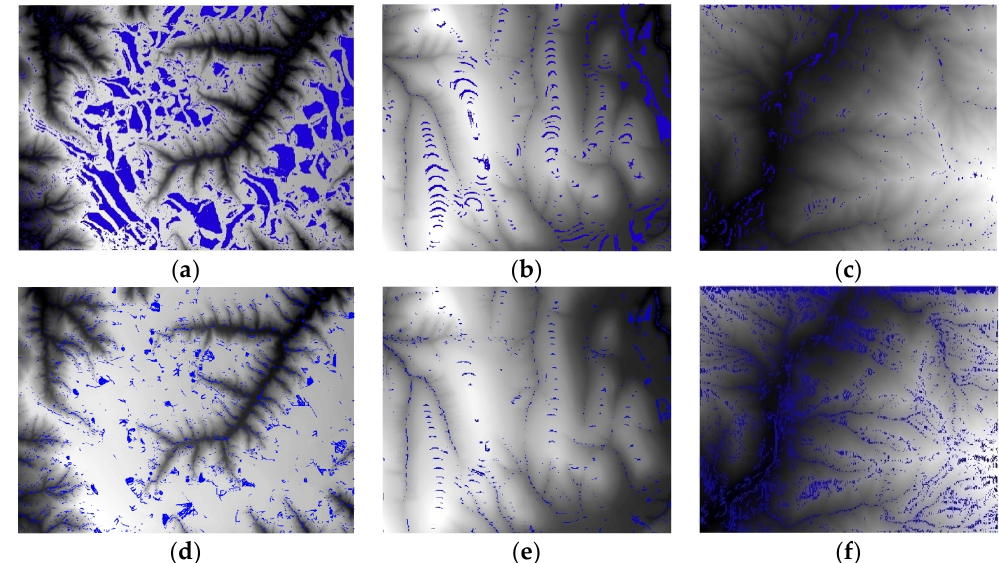
Figure 11. Spatial distribution of the slope error (the blue parts in ( a – c ) respectively indicate all grid cells of study area 1, study area 2, and study area 3 with relative errors greater than 100%; the blue parts in ( d – f ) respectively indicate all grid cells of study area 1, study area 2, and study area 3 with absolute slope errors greater than 15°).